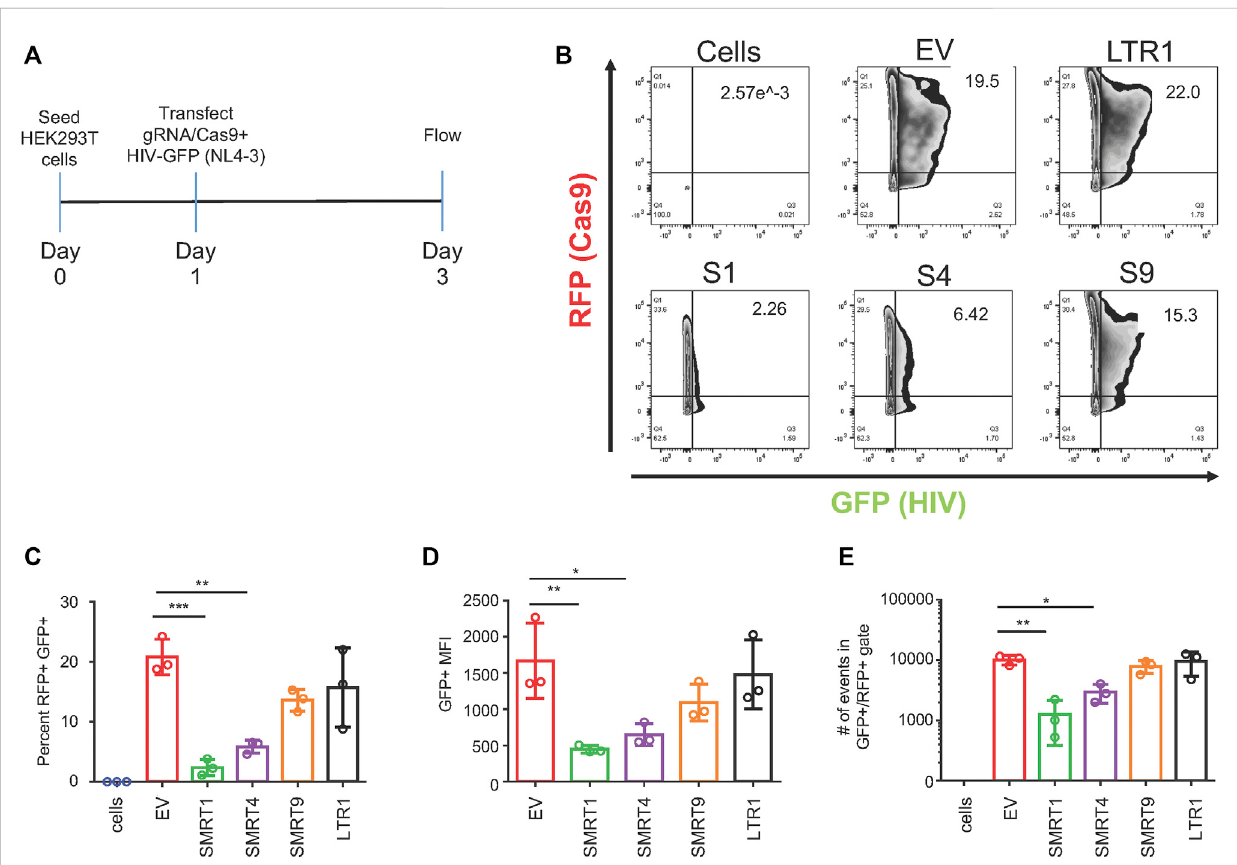
FIGURE 4 Co-transfections with a3:1 ratioof HIV-1 GFPto Cas9 maintains SMRT1 and SMRT4s ability to signi fi cantly reduce HIV-1 GFP expression. HEK-293T cells were transfected in a 24-well plate with 750 ng of HIV-1 GFP and 250 ng of Cas9 plasmid. Forty eight hours post transfection, cells were processed for fl ow cytometry. (A) A schematic representation of the experimental timeline. (B) Representative FACS plots showing gating for double-positive cells. (C) Quantitativerepresentation ofdouble-positivecells, (D) Mean fl uorescentintensity ofGFPfrom double-positivecells, (E) totalnumberofevents inthedouble-positivegate.Errorbarsrepresent±SD.Statisticalsigni fi cancewasdeterminedbyusingaOne-wayANOVAwithmultiplecomparisons. p = * < .05, ** < .01, *** < .001. Data was collected from three independent